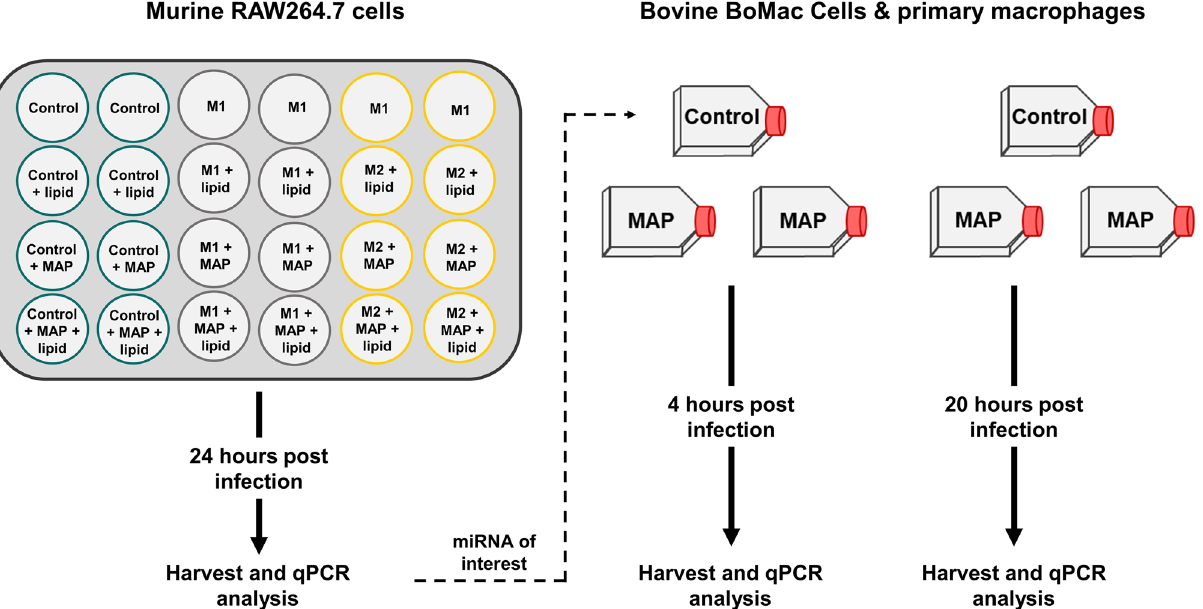
Figure 7. Experimental overview. Graphical illustration of cultured murine and bovine cells. Murine RAW264.7 cells were polarised to an M1 or M2 phenotype and further infected with MAP and/or supplemented with lipid. miRNAs of interest were then analysed in control uninfected or MAP-infected BoMac cells and primary bovine 4 online databases (Ingenuity Pathway Analysis, microT-CDS 5.0, miRWalk 2.0, TargetScan 7.2) were queried for miRNA-mRNA interactions. Potential lipid-associated miRNAs were selected if they appeared in at least 2 databases and showed experimentally observed or moderate-high predicted targeting of the genes of interest. Preparation of bacterial suspension. Frozen bacterial suspensions (S strain Telford 9.2; C strain C0912),